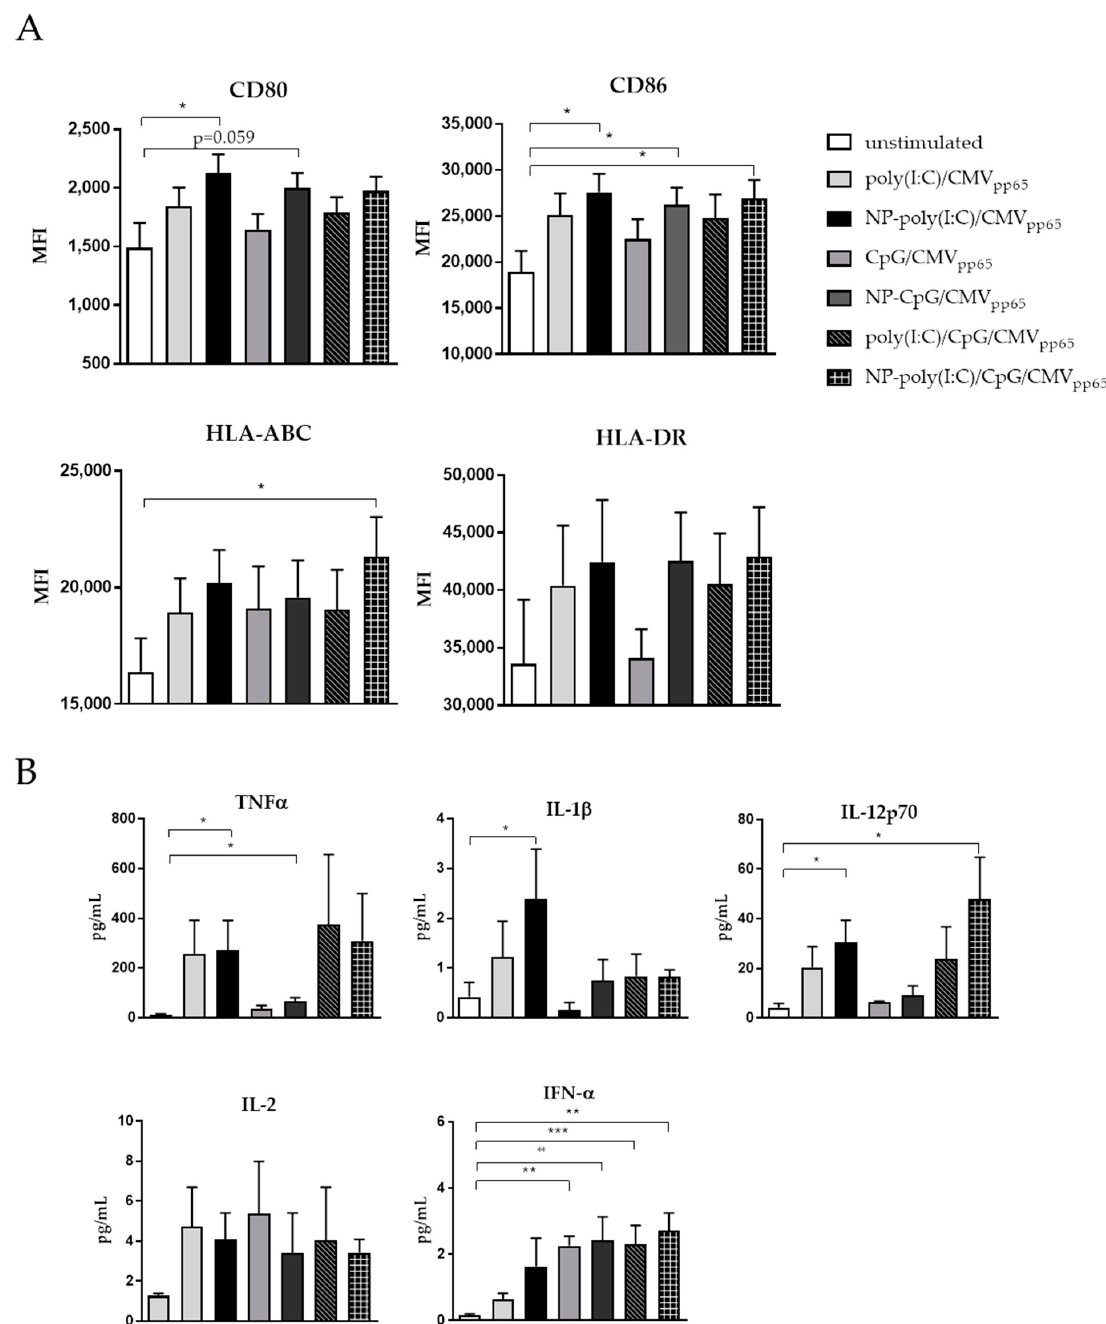
Figure 4. Maturation of monocyte-derived DCs (mDCs) by functionalized CaP nanoparticles. ( A ) mDCs were stimulated with poly(I:C), CpG or poly(I:C), and CpG functionalized CaP NPs or soluble ligands. The expression of the costimulatory molecules CD86, CD80, HLA-ABC, and HLA-DR was analyzed 24 h after stimulation by flow cytometry. ( B ) Supernatants from stimulated mDCs were investigated for proinflammatory cytokines after 24 h. Results are summarized from at least four independent experiments. Bars represent means with SEM. One-way ANOVA was used when followed by the Tukey’s multiple comparisons test. * p < 0.05. ** p < 0.01. *** p < 0.001. Subsequently, we incubated the CaP NP stimulated matured mDCs with CD8 + T cells isolated from the blood of CMV-positive patients and analyzed the expansion of CMV-specific CD8 + T cells.